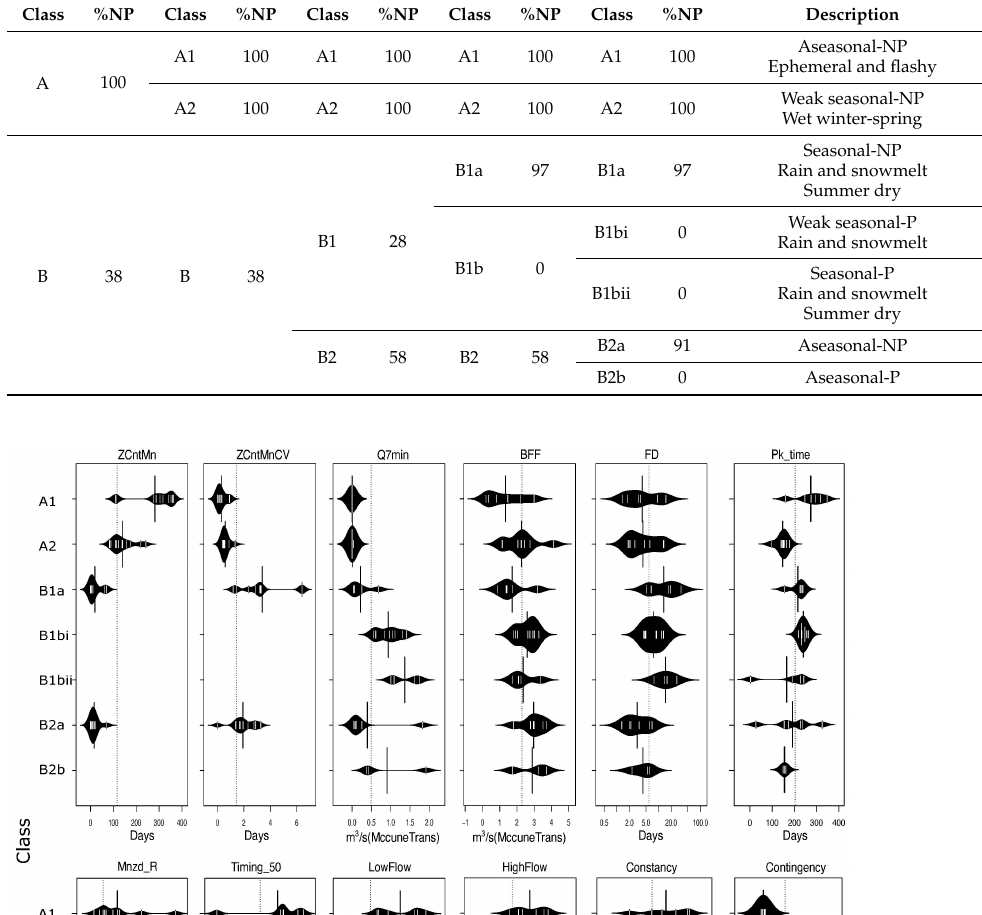
Table 3. The percent of nonperennial (NP) reaches in each hierarchical class and general descriptions of the flow regimes of the seven-group classification. P = perennial.